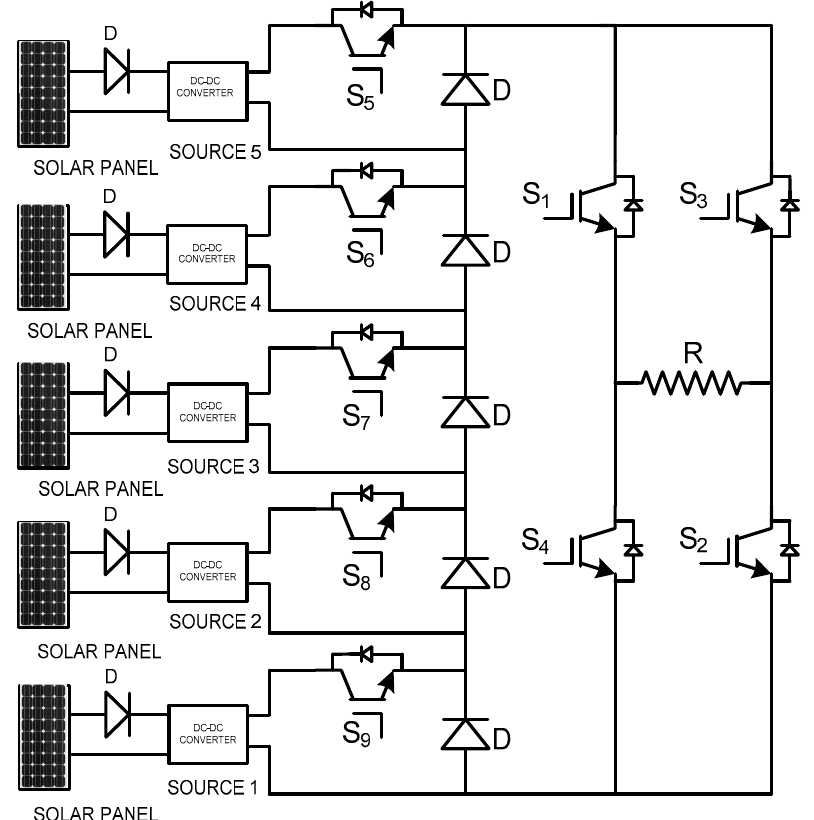
Figure 8. 31-level reduced switch multilevel inverter.